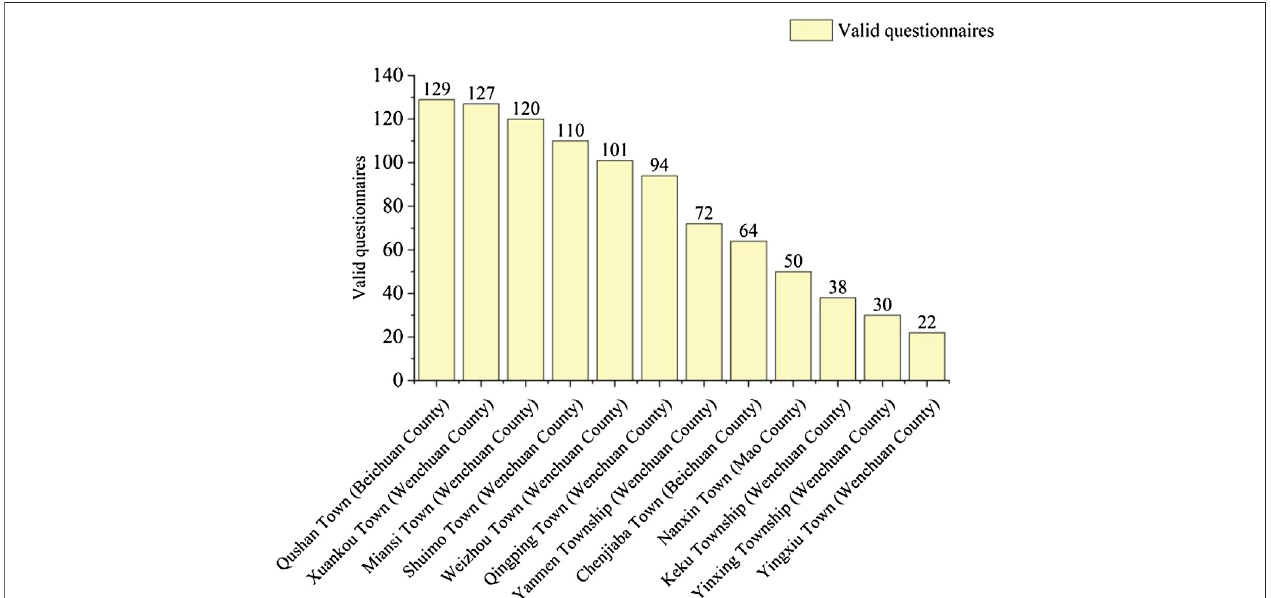
FIGURE 2 | Valid questionnaires in different regions and